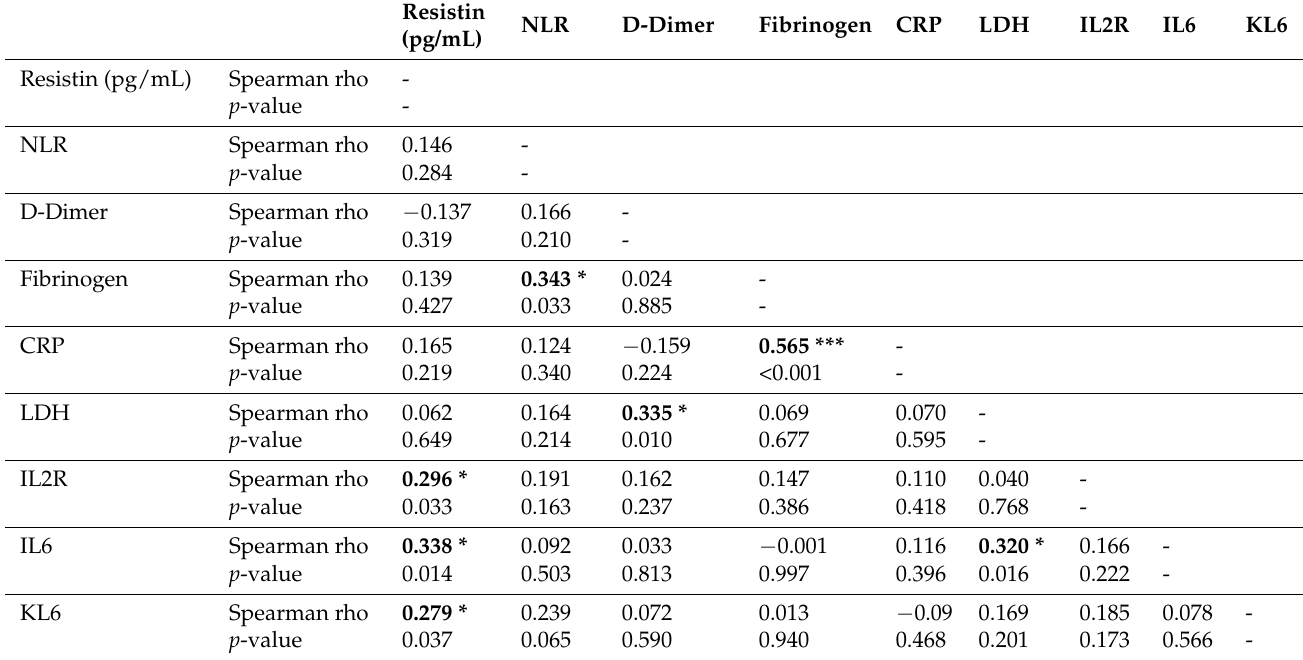
Table 3. Correlation between resistin and inflammatory